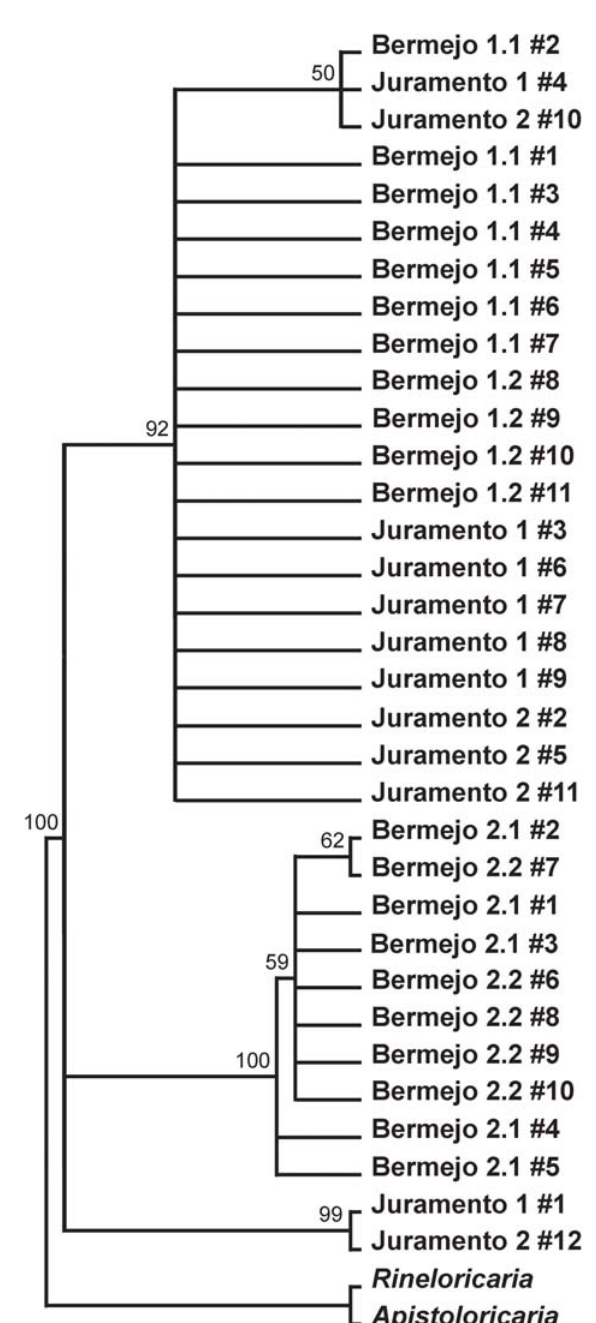
Fig. 1. Plots of factor scores of principal component analysis of four populations of Ixinandria steinbachi . Dot, río Juramento basin; Square, southern upper río Bermejo basin; triangle, northern upper río Bermejo basin; and Star, río Pilcomayo. L = lectotype.